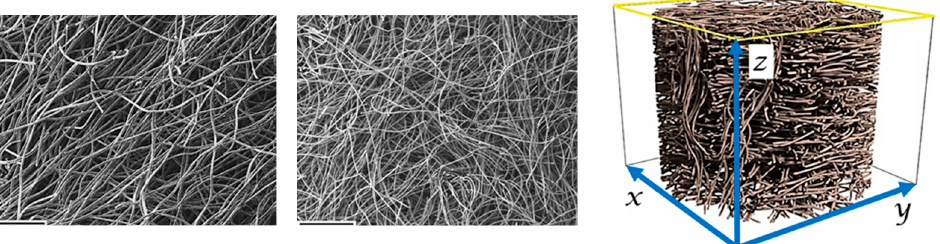
Figure 1. “In-plane” SEM micrographs of PAN and RC carbon felts, and schematic representation of soft felt samples, with x , y , z orientations of the fibers: x , y orientations are defined as “in-plane”; z orientation is defined as “out-of-plane”. The scale bar in the lower left corner of the SEM images is 500 µm long.